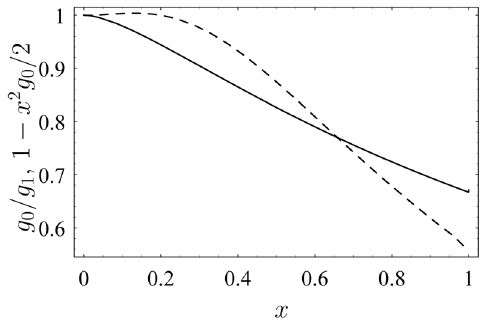
(cid:3) versus propagation distance a FIG. 2. Aspect ratio x (cid:1) a= (cid:2) (cid:7) 0 3 s (mm) for an initial transverse radius a (cid:1) 19 (cid:4) m , longitudinal (cid:1) 77 (cid:4) m , divergence x 0 (cid:1) 2 : 5 mrad , energy half-length a 3 (cid:1) 13 : 7 spread (cid:5) (cid:1) 42 : 8% and beam relativistic factor (cid:7) 0